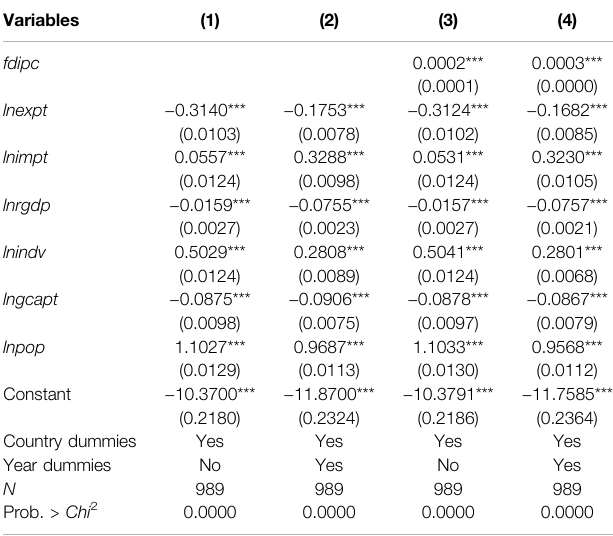
TABLE 2 | Results of regressions on carbon emissions.